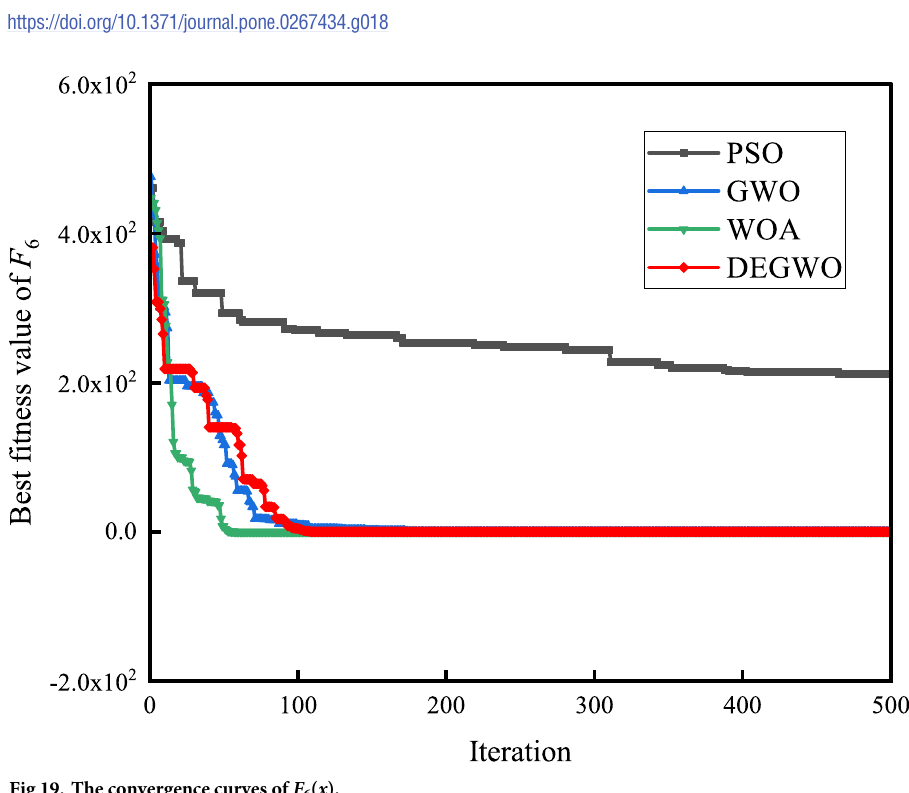
Fig 19. The convergence curves of F 6 ( x ).